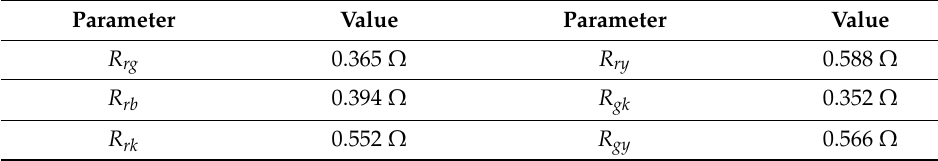
Figure 10. Detailed steps of phases sequence identification. Table 2. The obtained measured resistances.